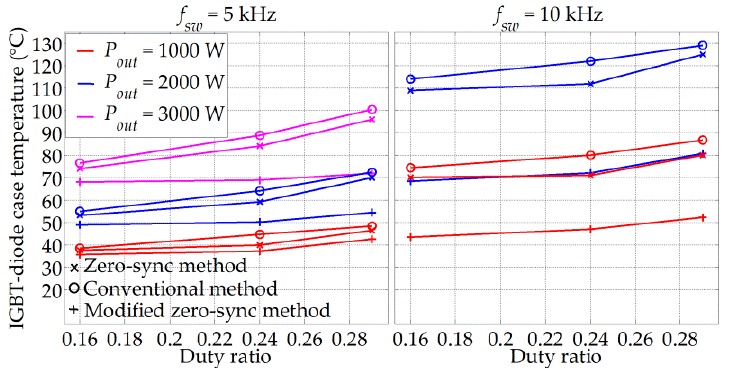
Figure 21. Measured IGBT-diode case temperature as a function of the duty ratio for different load power values. power